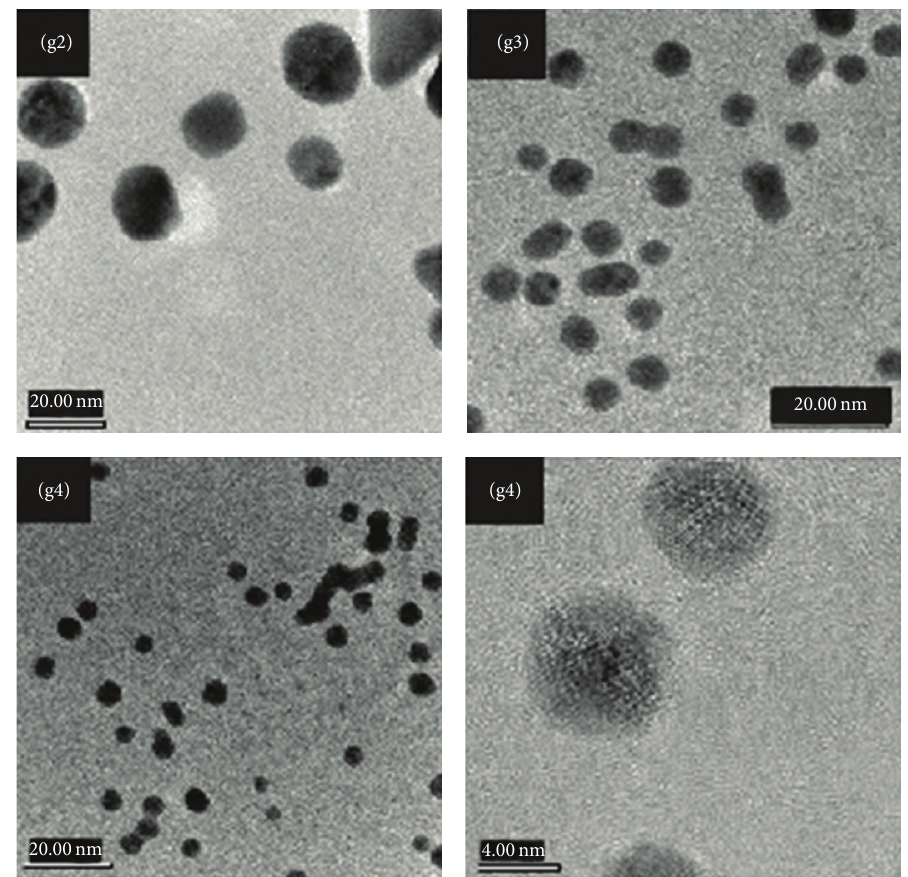
Figure 2: Transmission electron micrograph (TEM) of gold colloids g2, g3, and g4 synthesized in the presence of added TA with concentra- tions of 5.9 × 10 −7 , 5.9 × 10 −6 , and 4.1 × 10 −5 mol, respectively.